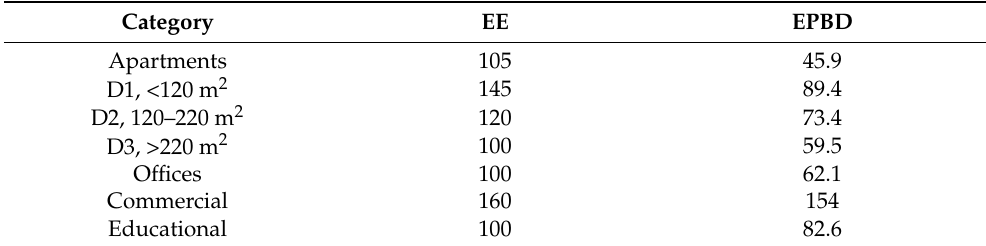
Table 3. NZEB values (kWh/(m 2 a)) according to the Estonian regulation EE (left) and to the current European Directive EPBD (right). The EPBD does not include plug loads (non-residential) or plug loads and lighting (residential) [23].